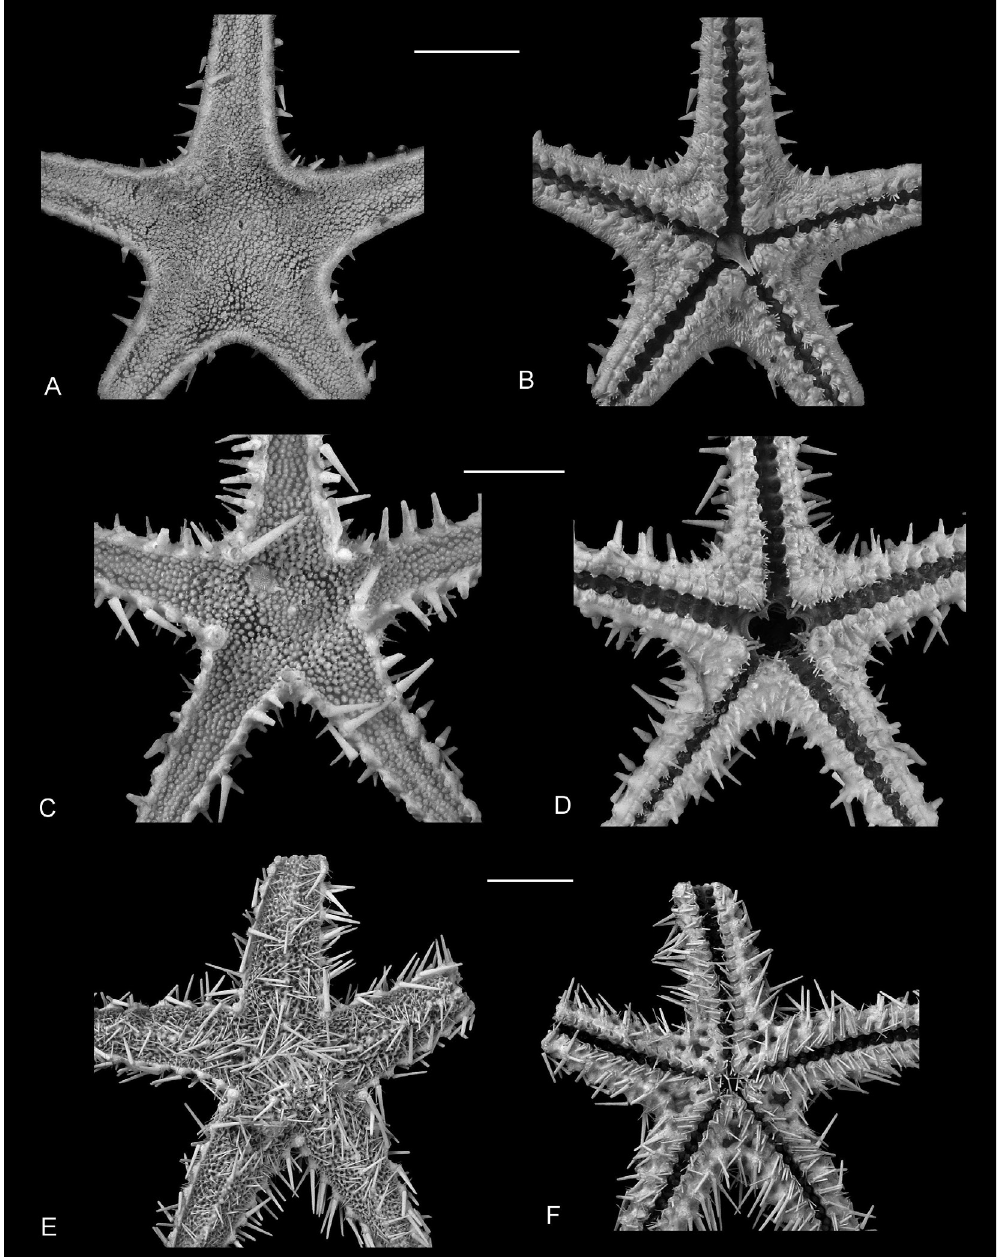
Fig. 2. A–B . Pectinaster filholi Perrier, 1885, Recent, in abactinal (A) and actinal (B) views, Porcupine Trough, NE Atlantic (A.S. Gale collection, unregistered). C–D . Benthopecten simplex (Perrier, 1881), Recent, in abactinal (C) and actinal (D) views, Rockall Trough, NE Atlantic (NHMUK EE 13563). E–F . Nearchaster aciculosus (Fisher, 1910), Recent, in abactinal (E) and actinal (F) views, NE Pacific (USNM, unregistered). Scale bars: A–B = 7 mm; C–D = 6 mm; E–F = 20